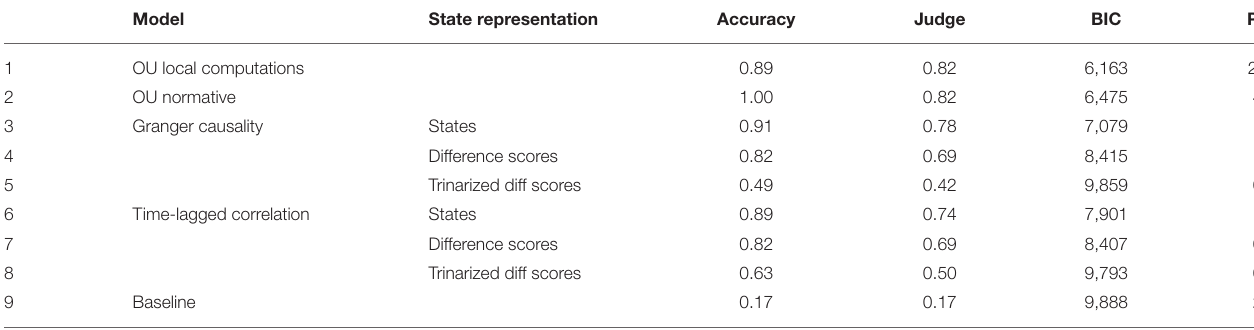
TABLE 1 | Summary of model accuracy and